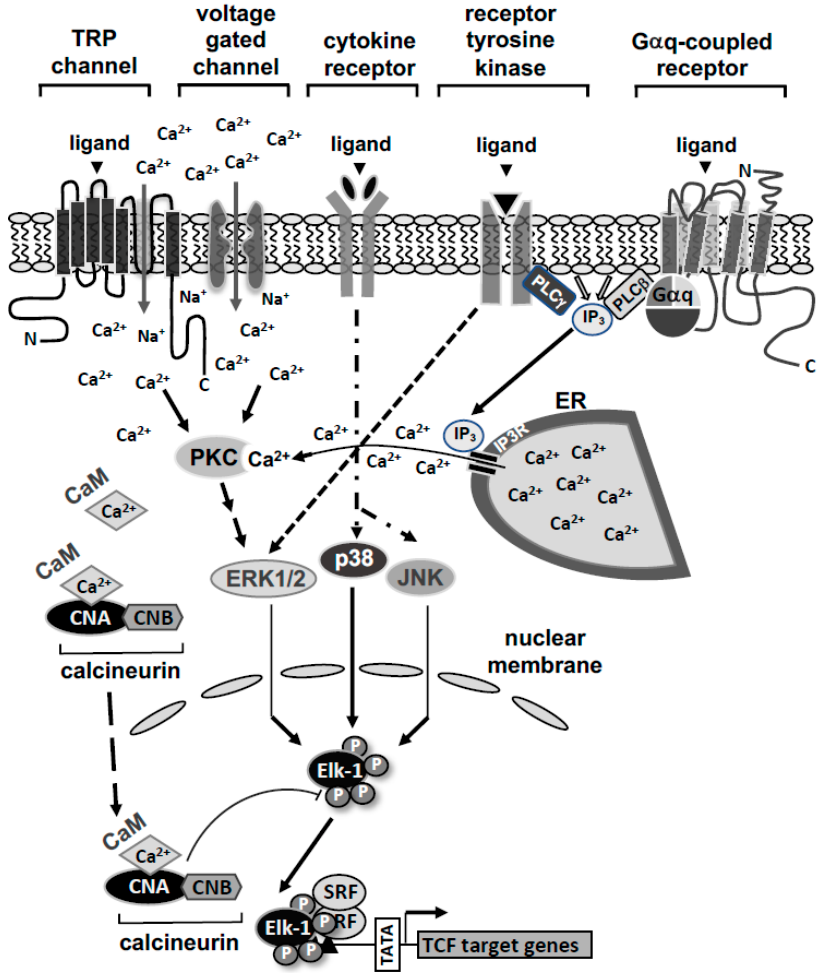
Figure 2. Stimulus-transcription coupling involving Elk-1. There are numerous receptors and ion channels expressed at the surface of mammalian cells that are necessary for the communication of the cells with their environment. Ligands of G protein-coupled receptors, receptor tyrosine kinases